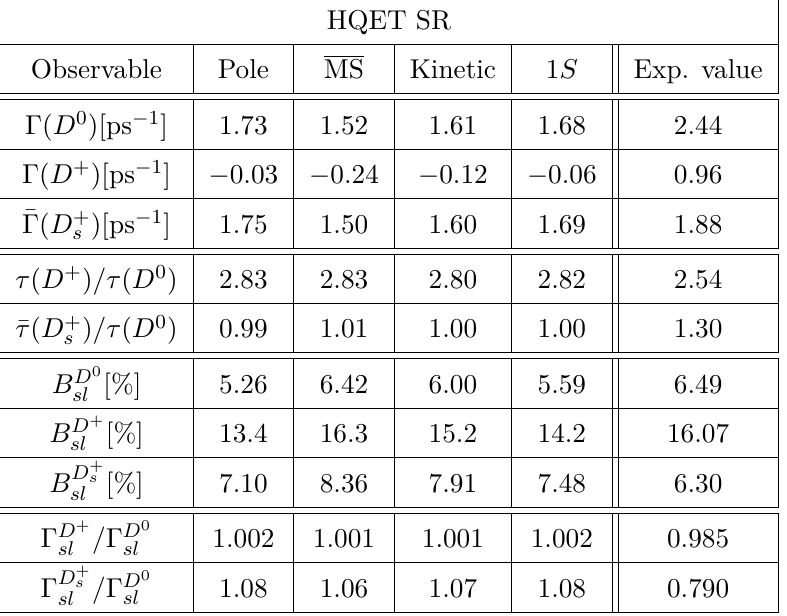
Table 14 . Central values of the charm observables in different quark mass schemes using HQET sum rule results [66, 68] for the matrix elements of the 4-quark operators compared to the corresponding experimental values (last column).